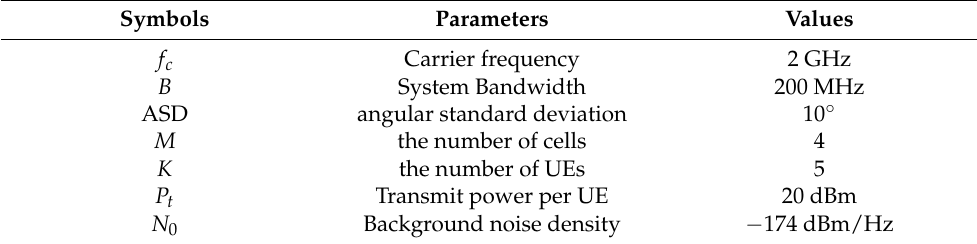
Table 2. Parameter